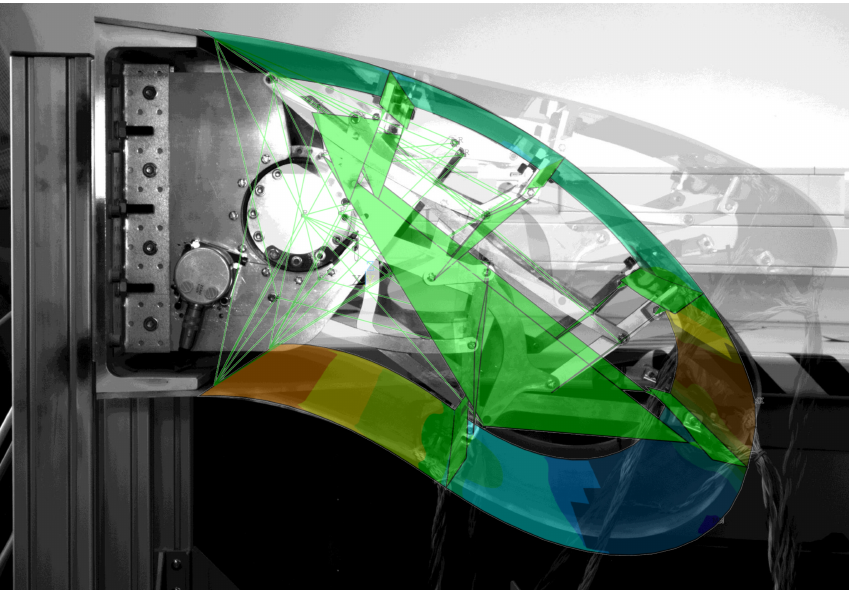
Figure 15. Qualitative shape comparison between finite element analysis and the experimental test. (Contours of chordwise strain from finite element results are